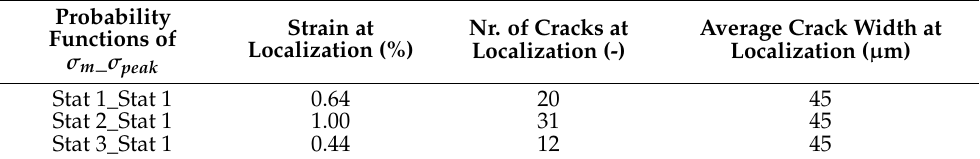
Table 5. Macroscopic strain at localization, average crack width, and degree of multiple cracking depending on the distribution function of the matrix strength. Data correspond to Figure 8. Probability Functions